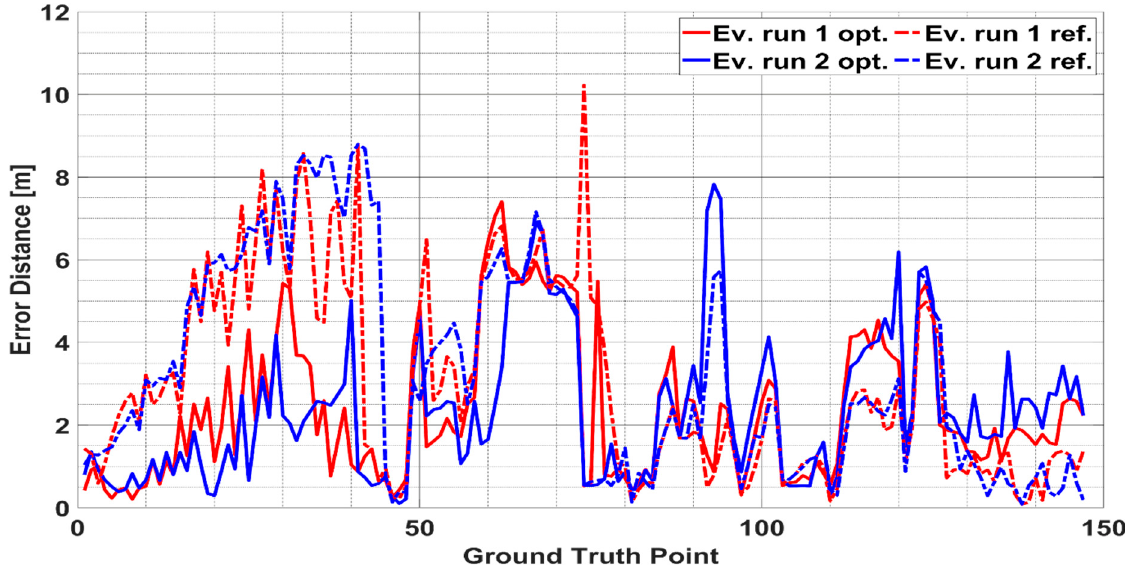
Figure 10. Position deviation of the evaluation runs for the LG V30. Table 4. Characteristics of the LG evaluation runs.